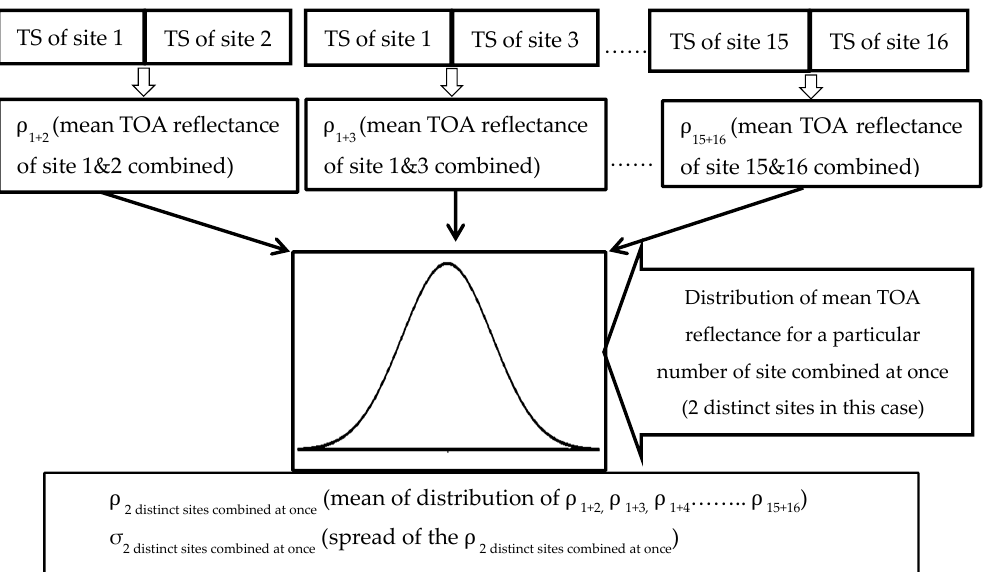
Figure 7. Procedure to create analysis dataset for determining expected behavior of random Cluster 13 location.